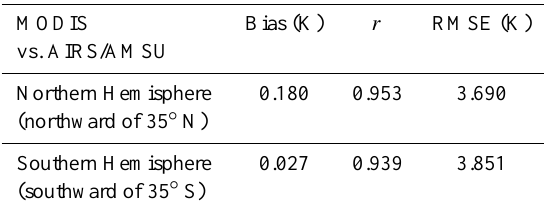
Table A1. Comparison of 9-day composite T skin (MODIS ICE) and T skin (AIRS/AMSU). Bias: MODIS minus AIRS/AMSU, r : correlation coefficient, RMSE: root mean square error. MODIS